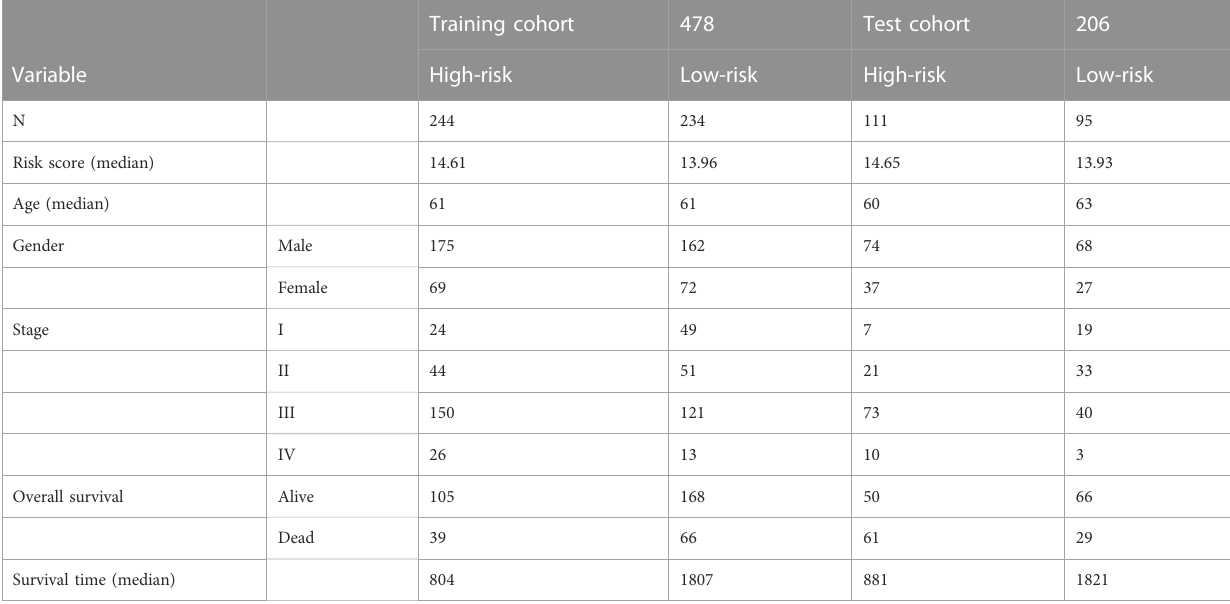
TABLE 1 Clinicopathological